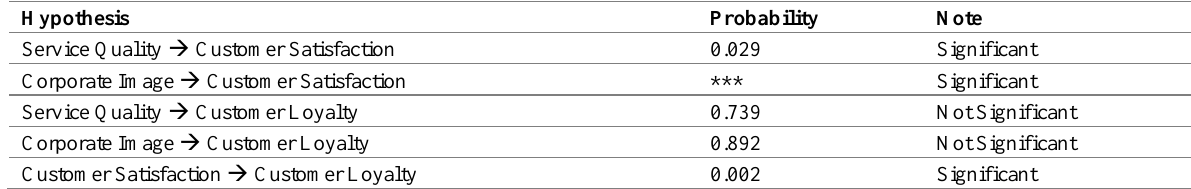
Table 4 : The Probability Value Among